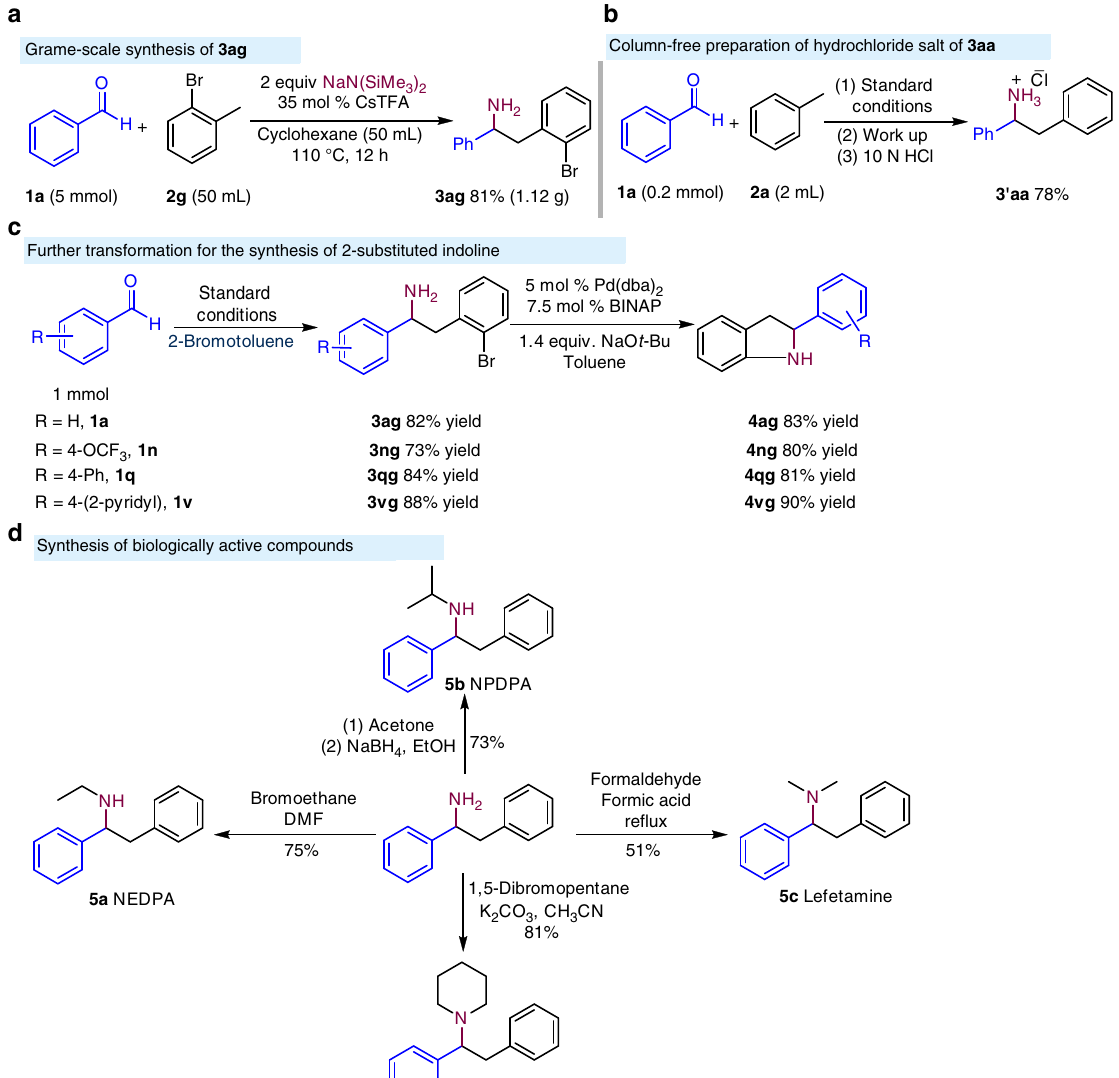
Fig. 3 Possible reaction pathway for the aminobenzylation. In situ imine formation provides aldimine B while NaN(SiMe 3 ) 2 /CsTFA-mediated benzylic deprotonation generates transient organometallic C . Intermediate C is trapped by B to furnish intermediate D . Workup then affords the desired amine product